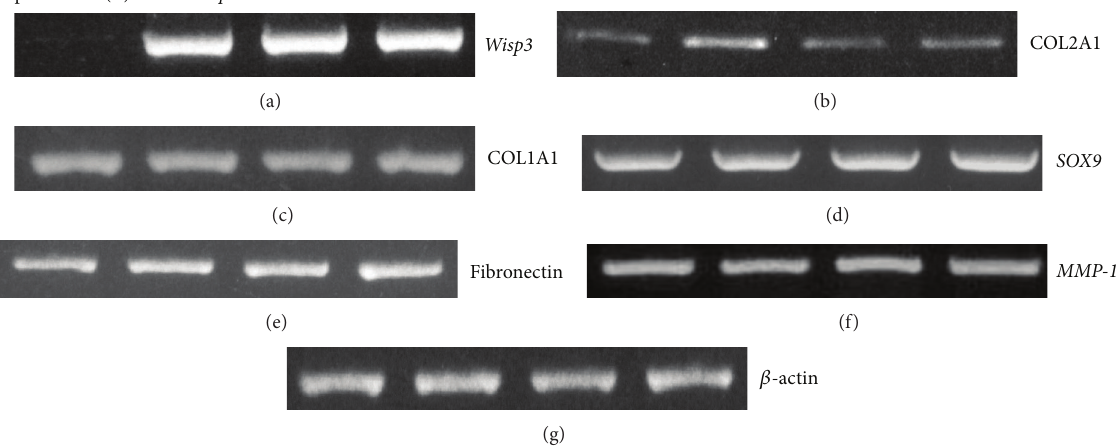
Figure 4: mRNA expression of cartilage-specific genes in C20/A4 cells transfected with wild and mutant Wisp3 . Cells stably transfected with WT- Wisp3 /pcDNA3.1(+), MUT 1000 T / C /pcDNA3.1(+), MUT 840 delT /pcDNA3.1(+), or empty vector. mRNA expression of cartilage-specific genes in C20/A4 cells was determined by RT-PCR. (a)–(g) represent Wisp3 , COL2A1, COL1A1, SOX9 , fibronectin, MMP-1 , and 𝛽 -actin